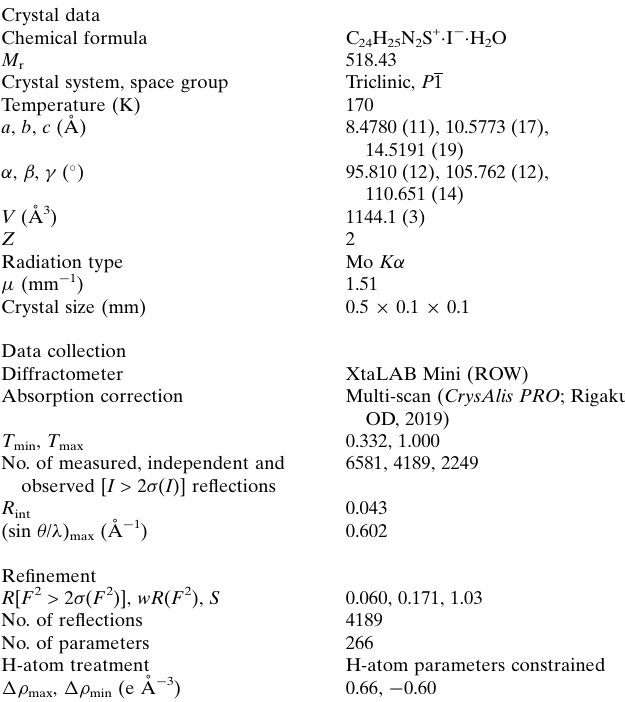
Table 2 Experimental details. Crystal data Chemical